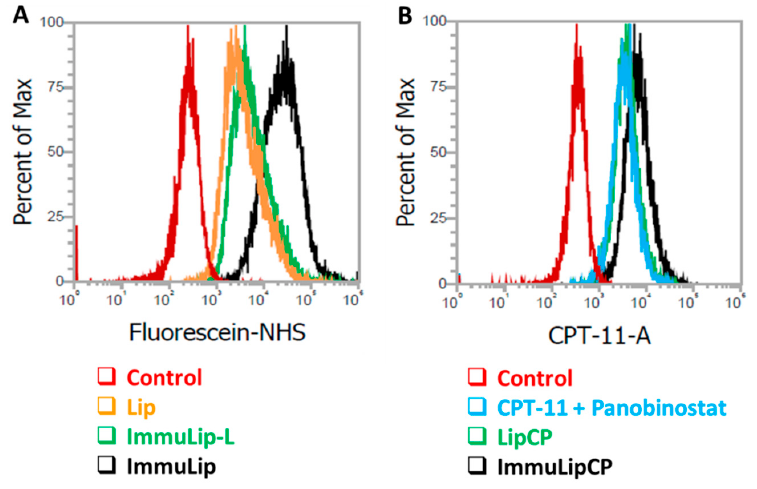
Figure 5. ( A ) The intracellular liposome uptake efficiency from flow cytometry analysis after incubating U87DR cells with fluorescein-labelled Lip, ImmuLip-L and ImmuLip for 24 h. ( B ) The intracellular drug uptake efficiency of from flow cytometry analysis of CPT-11 blue fluorescence after incubating U87DR cells with free drugs (CPT-11 + panobinostat), LipCP and ImmuLipCP for 24 h.